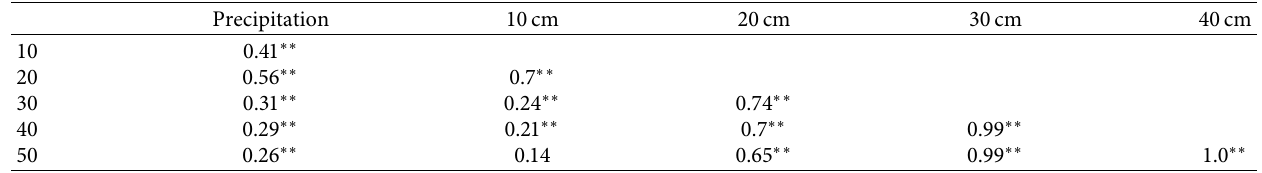
Figure 7: Precipitation and SM levels in the soil profile at Jiali from May to October 2015. Table 3: Correlations between precipitation and SM through the soil profile at Zedang.